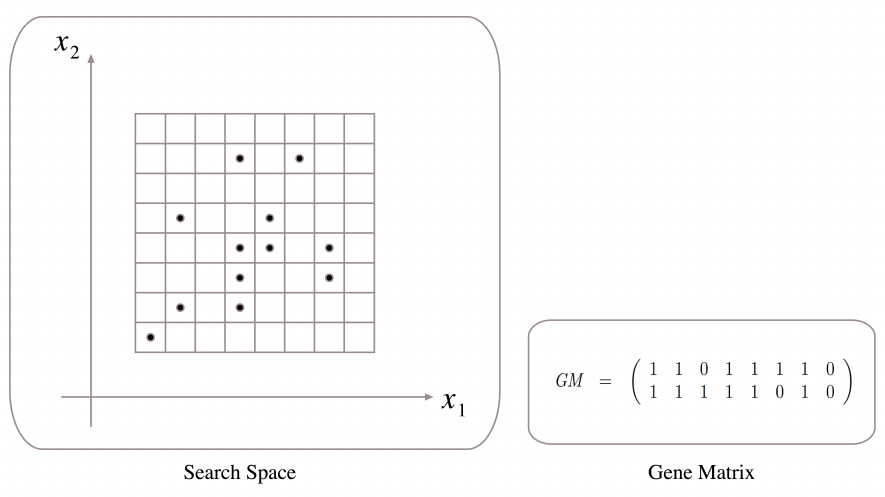
Figure 1. An example of GM in a two-dimension search